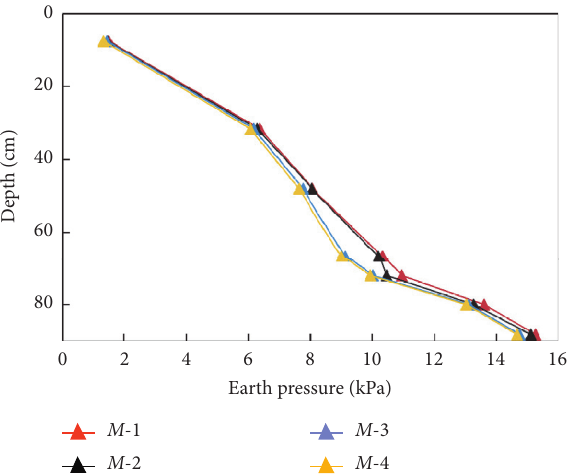
Figure 21: Earth pressure behind the wall of